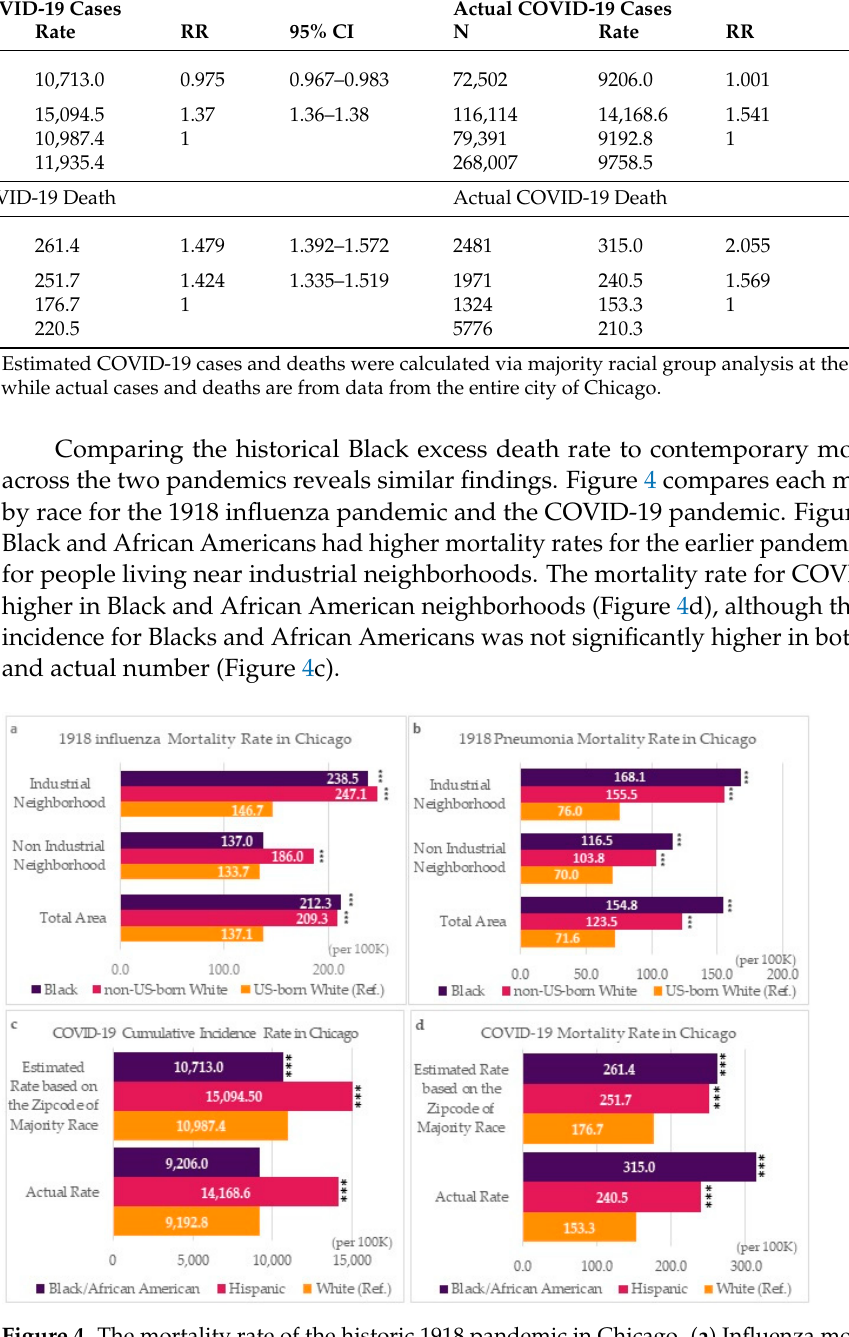
Figure 4. The mortality rate of the historic 1918 pandemic in Chicago. ( a ) Influenza mortality rate by race and industry area proximity, ( b ) Pneumonia mortality rate by race and industry area proximity, ( c ) COVID-19 cumulative incidence rate by race: comparison between the majority race neighbor-based estimation and true rate, and ( d ) COVID-19 mortality rate by race: comparison between the majority race neighbor-based estimation and true rate. (*** p < 0.001).